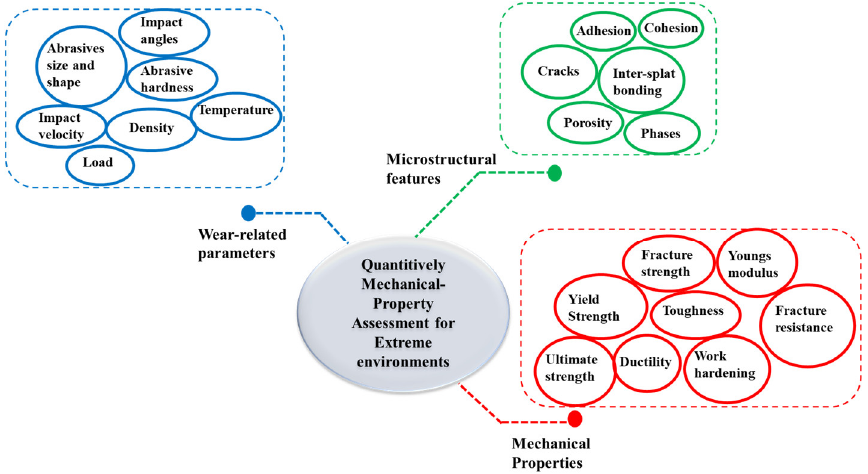
Figure 10. Schematic illustrating the classifications of material properties for quantifying the mechanical performance for extreme environmental applications.